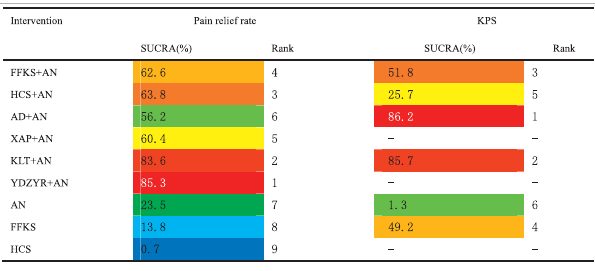
TABLE 3 | Surface under the cumulative ranking probabilities (SUCRA) results of ef fi cacy outcomes.